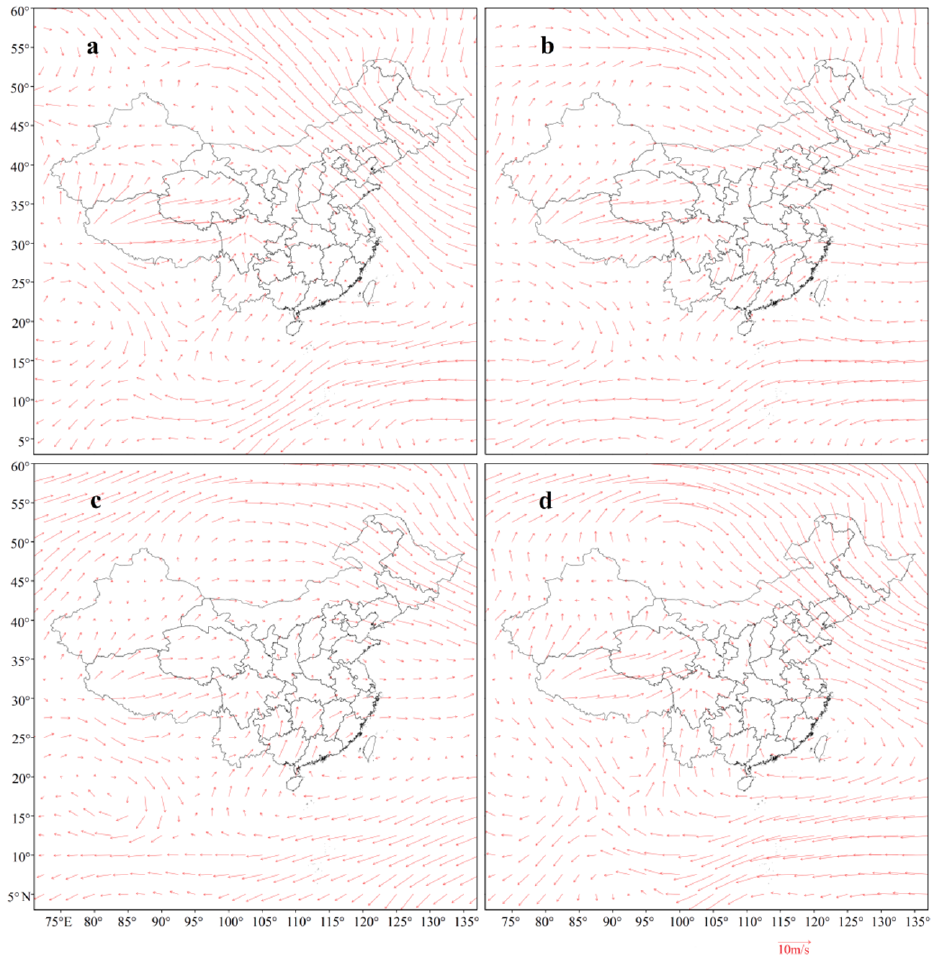
Figure 8. The wind field map of four seasons from China in 2019 (( a ): spring; ( b ): summer; ( c ): autumn; ( d ): winter).